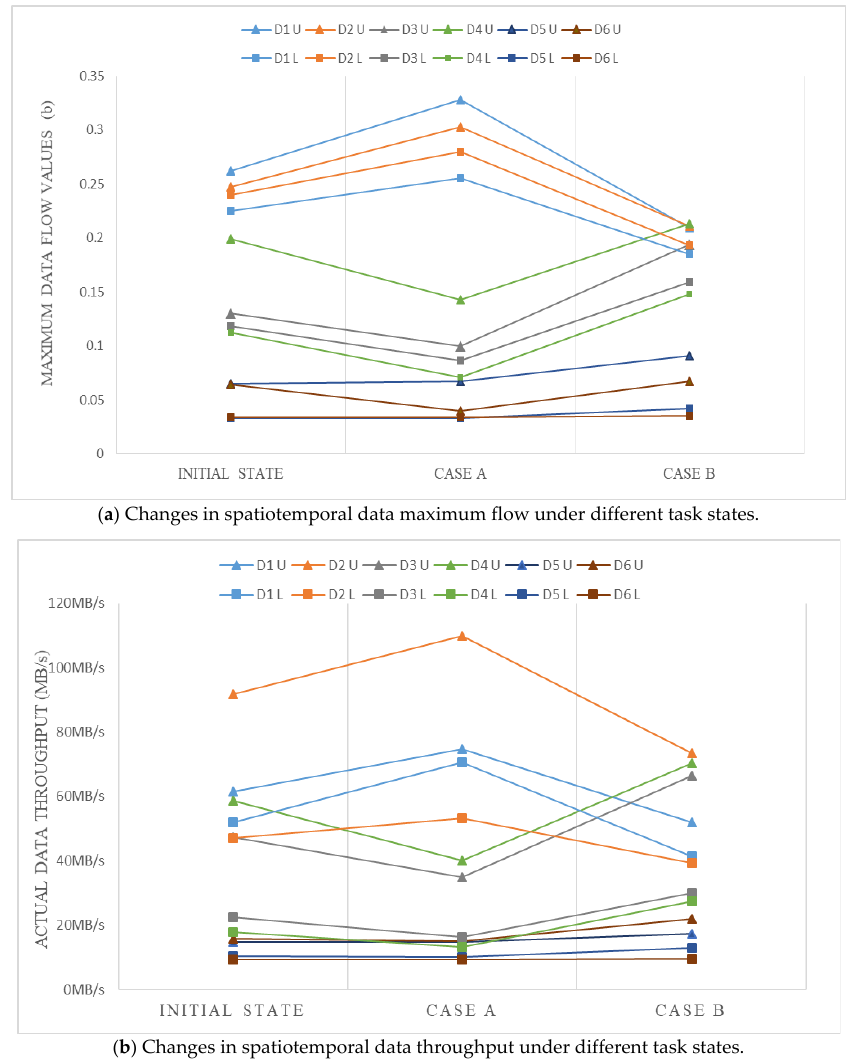
Figure 12. Adjustments of the maximum flow scheduling (MFS) model cause changes in the actual monitoring throughput.